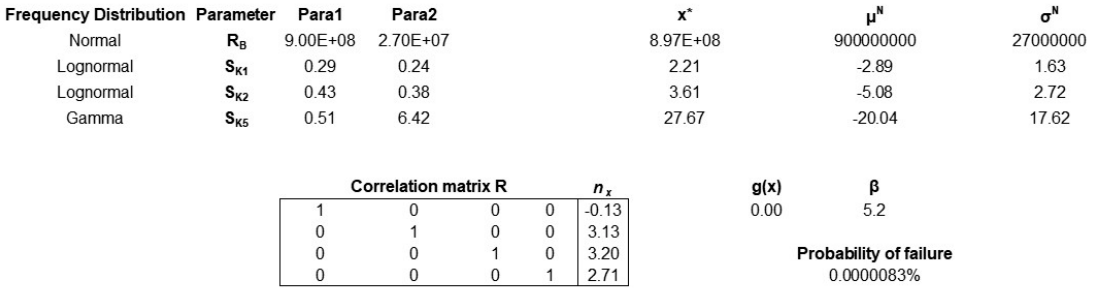
Figure 4. Determining the reliability index β and the coordinates of the design point x* for a hypothetical rockfall barrier.